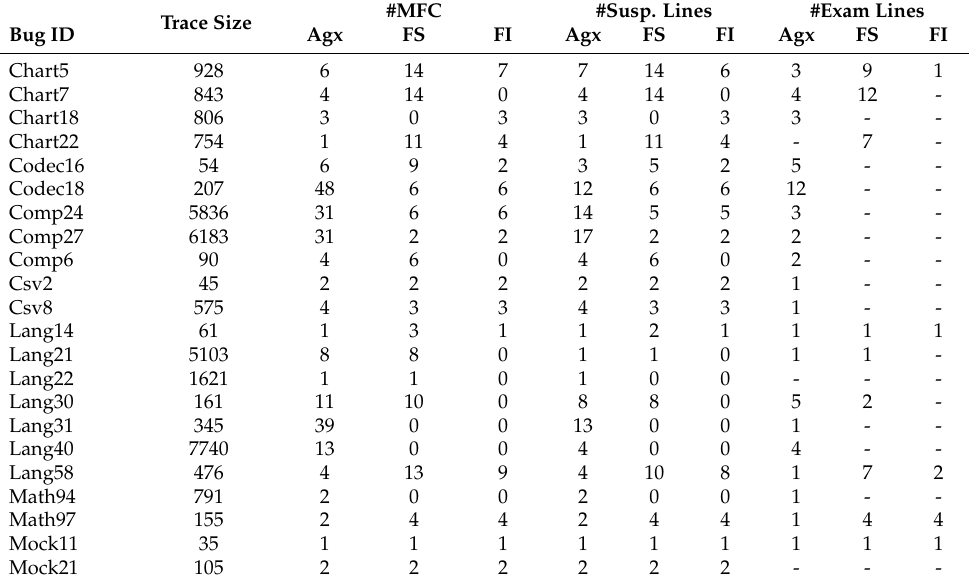
Table 5. Comparing the results of AgxFaults (Agx), Single-path Control-Flow-Sensitive (FS), and Single-path Control-Flow-Insensitive (FI) approaches on real